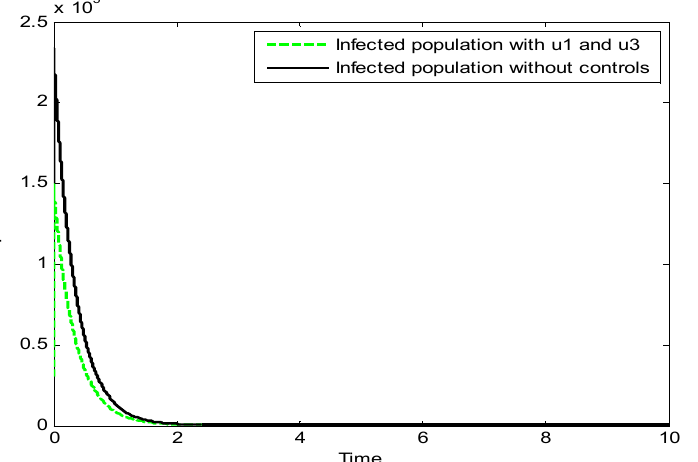
Figure 8. Comparing the dynamics of the infected population without control and with control 𝑢 (cid:2870) &𝑢 (cid:2871) . Figure 9 compares the effects of the three controls, i.e., 𝑢 (cid:2869) ,𝑢 (cid:2870) &𝑢 (cid:2871) on the dynamics of the infected population. The application of all the control measures in the partitioned sus- ceptible population leads to the desired outcome. This effect is clearly seen. Hence, to ob- tain the desired result, there is a need for awareness, and not only vaccinating the suscep- tible population but also making sure that a full dosage is given.